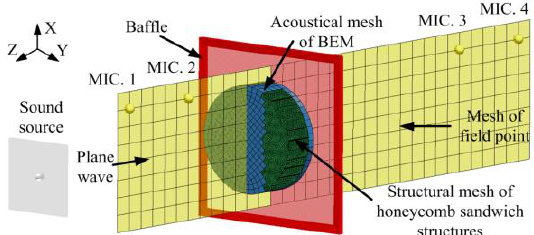
Figure 6. The mesh used to simulate a honeycomb sandwich structure. Figure 7. Simulating the measurement of STL using the boundary element method (BEM).